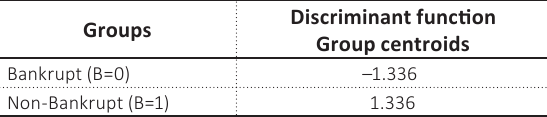
Table 5. Group centroids ( t –1)